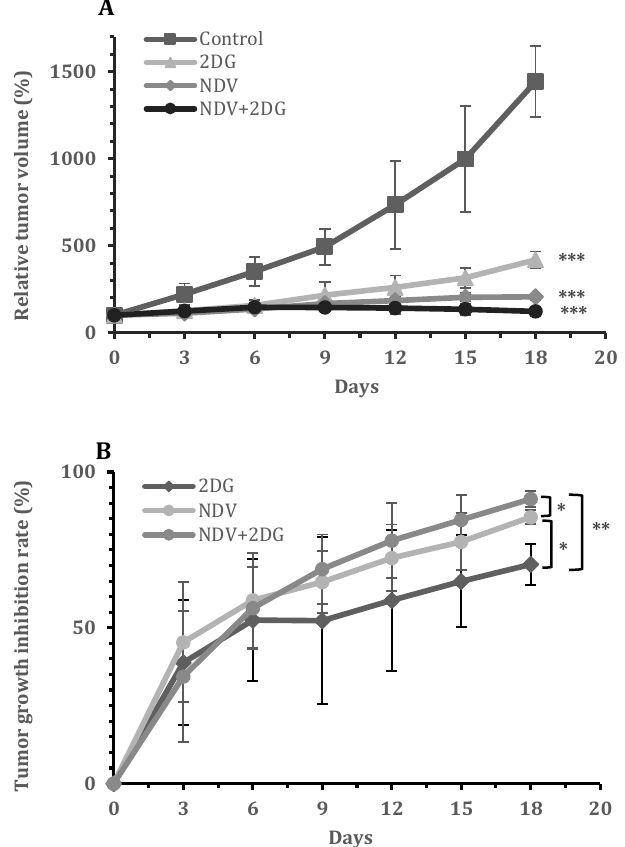
Figure 1. Anti-tumor efficacy of NDV, 2DG, and combination of both against breast cancer model of female mice. A) . Relative tumor volumes. B) .Tumor growth inhibition. ∗∗∗ P <0.001, ∗∗ P <0.01 and ∗ P <0.05 versus